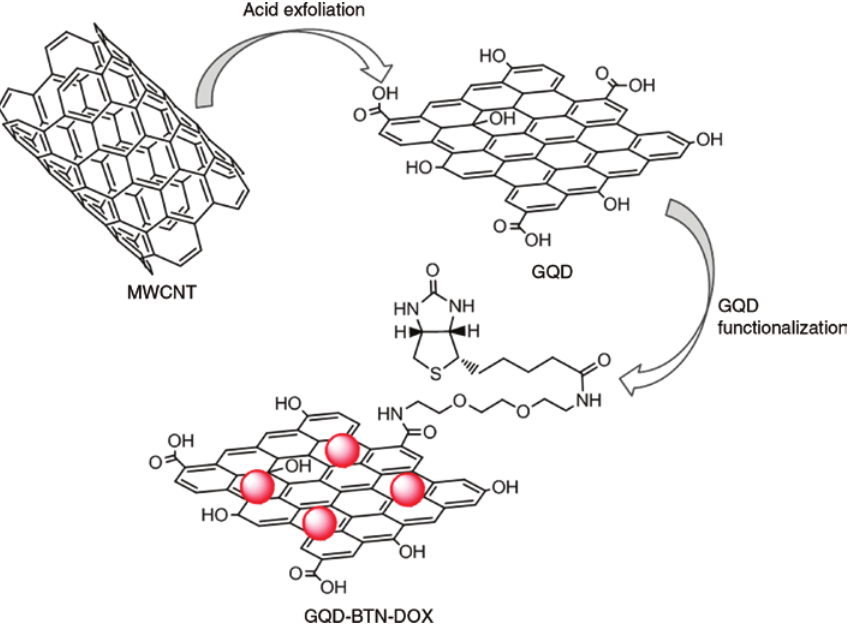
Figure 19: GQD for tumor-targeted DOX delivery (reprinted/reproduced with the permission of Ref. [124], copyright 2017, Elsevier